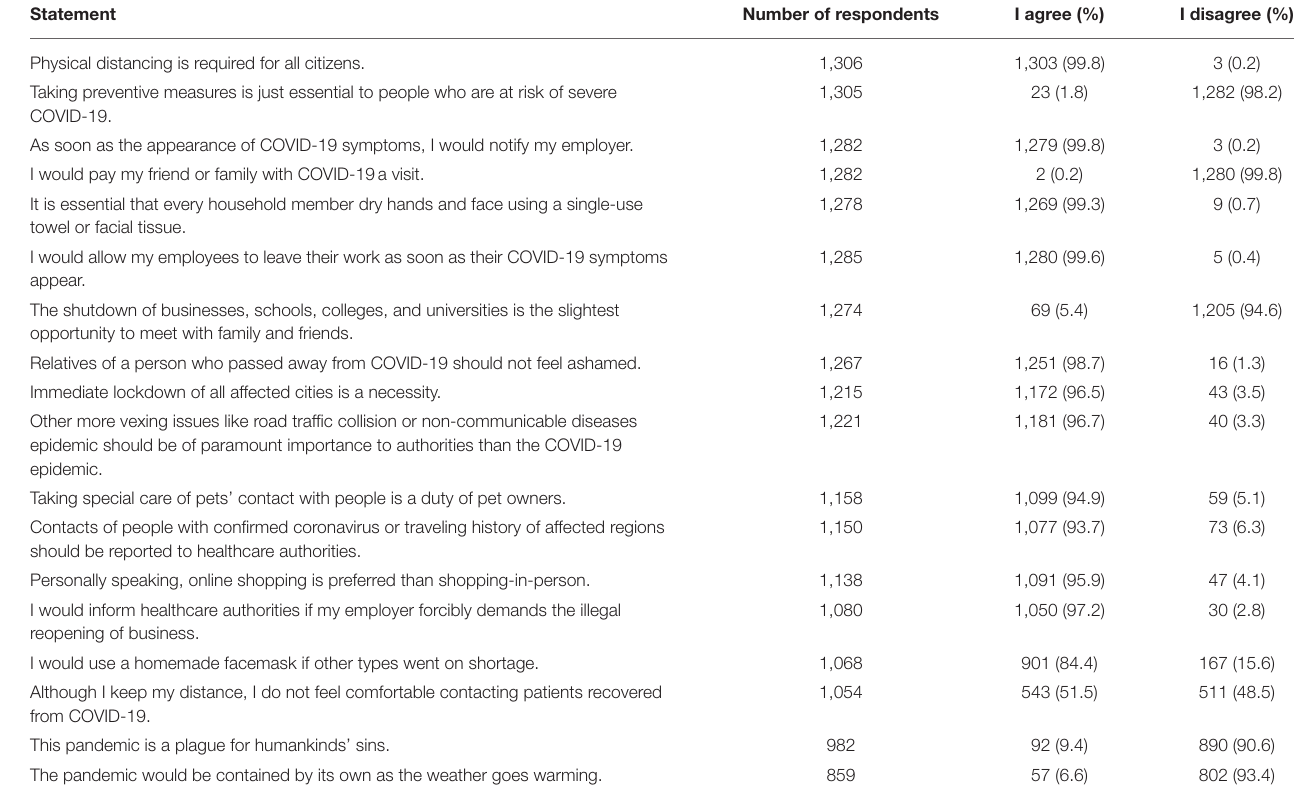
TABLE 6 | Attitudes of health care workers regarding the COVID-19 pandemic. Statement Number of respondents